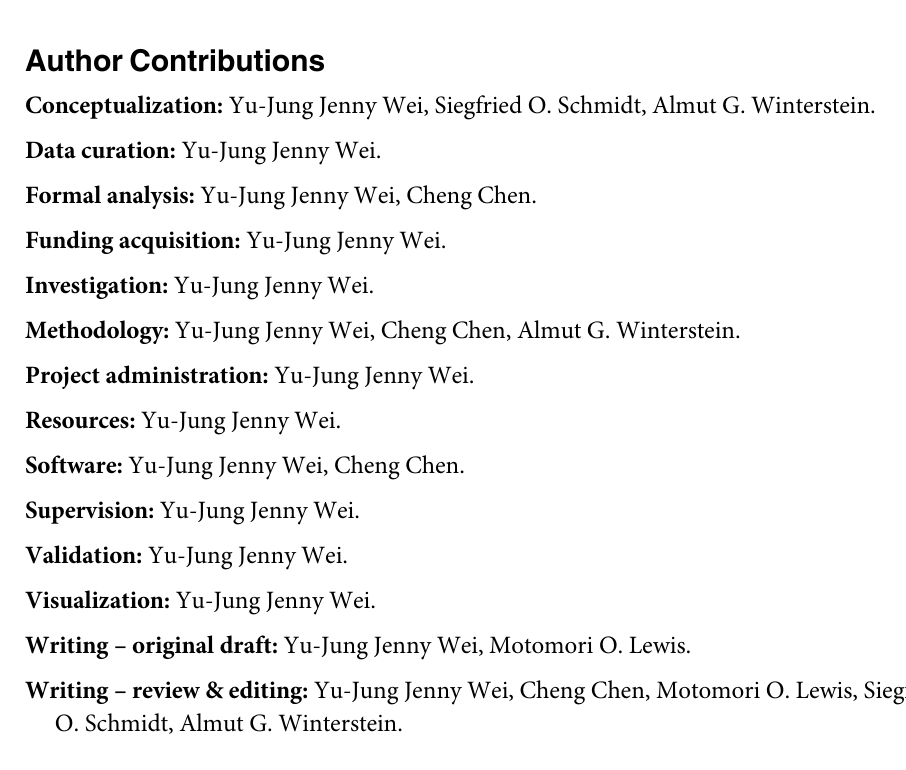
S4 Fig. Sensitivity analysis of trajectories of mean daily MME dose prescribed in each month over a randomly selected 6 months period in a cohort of older patients. MME, mor- phine milligram